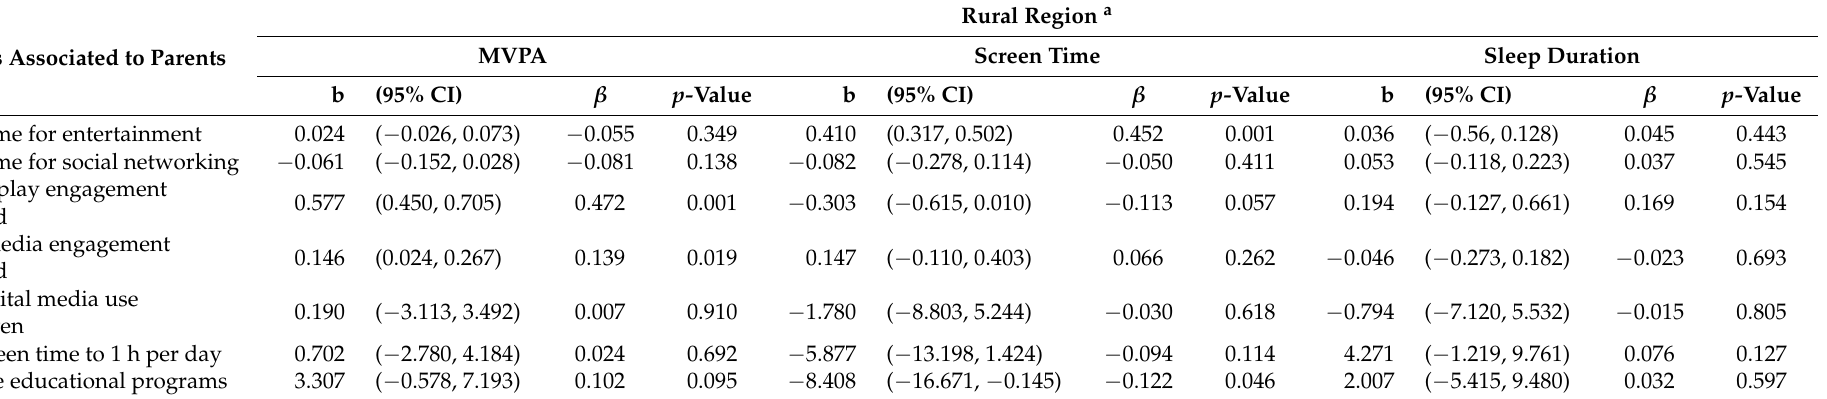
Table 5. Results from multiple regression analyses of 24-h movement guidelines and parents’ digital media habits, engagement, awareness for rural